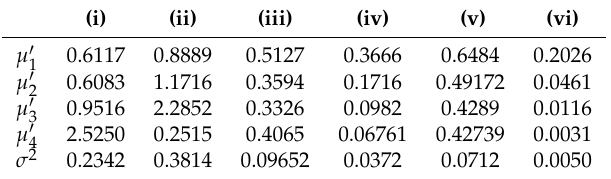
Table 1. Some moments and variance of X for the following parameters values respecting the